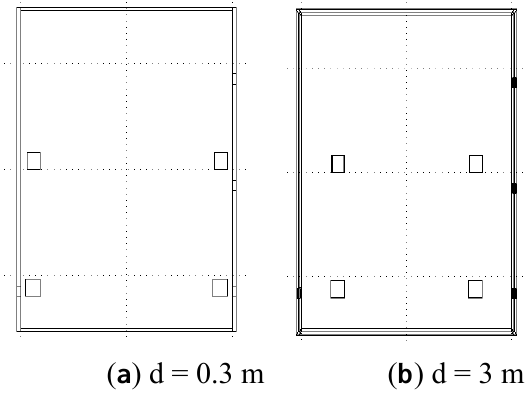
Figure 3. Schematic diagram of the models with different distances between the apparatus and wall.